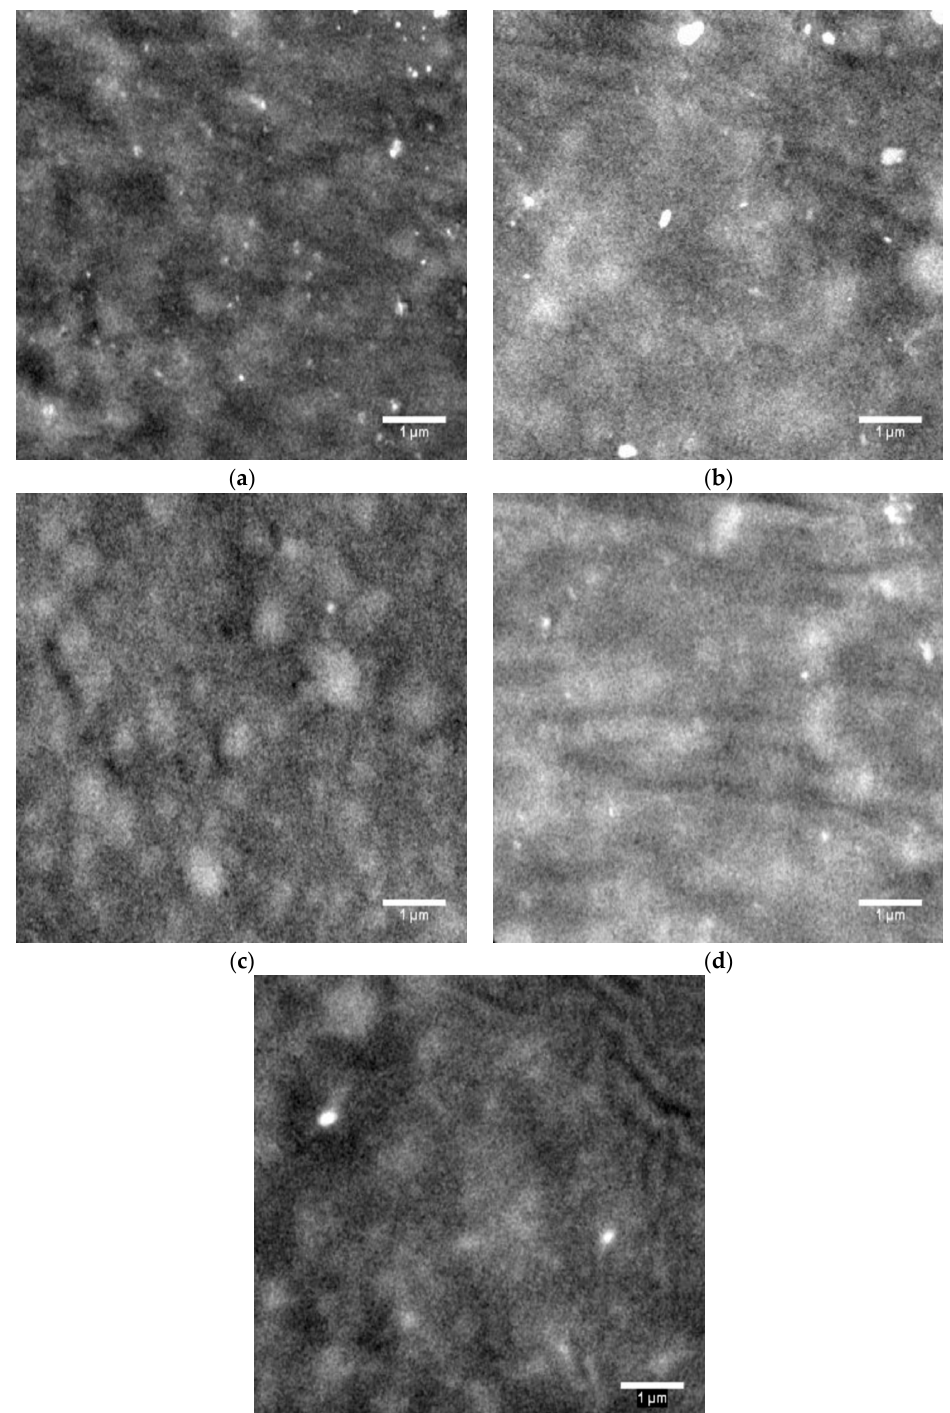
Figure 6. FESEM micrographs of ( a ) PVC-H plasticized with DOP; ( b ) PVC-H plasticized with DOP/palm oil-based alkyd (10 phr); ( c ) PVC-H plasticized with DOP/palm oil-based alkyd (20 phr); ( d ) PVC-H plasticized with DiNP/palm oil-based alkyd (10 phr); and ( e ) PVC-L plasticized with DOP/palm oil-based alkyd (10 phr). Field Emission Scanning Electron Microscopy (FESEM).